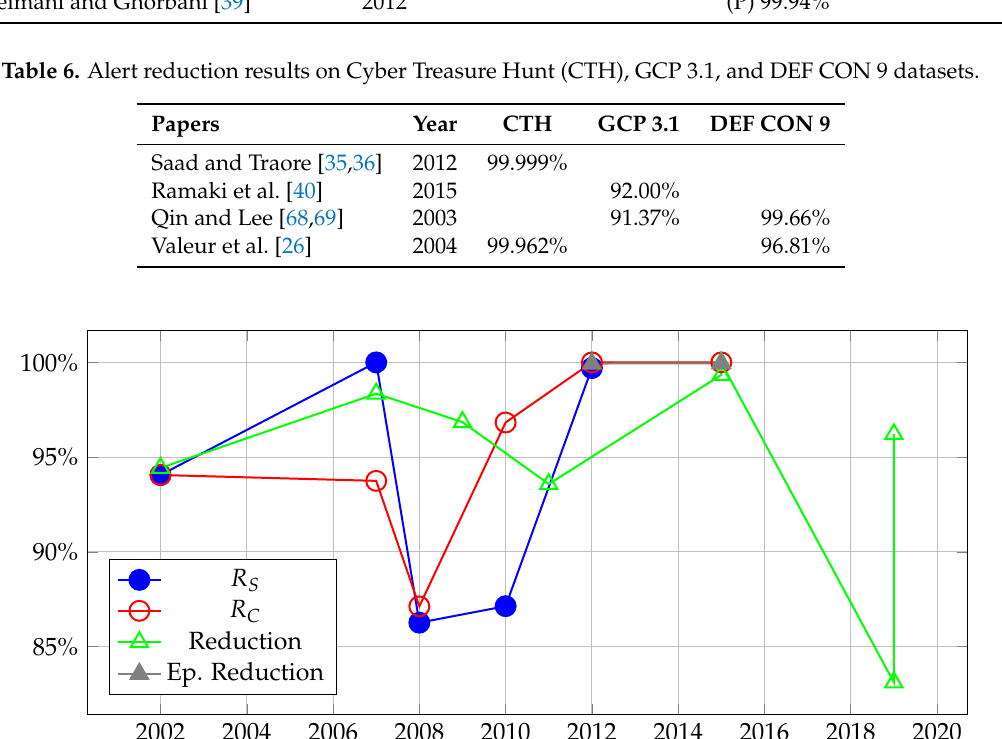
Figure 3. Scores achieved (percentages) on the DARPA 2000 LLDOS 1.0 scenario over